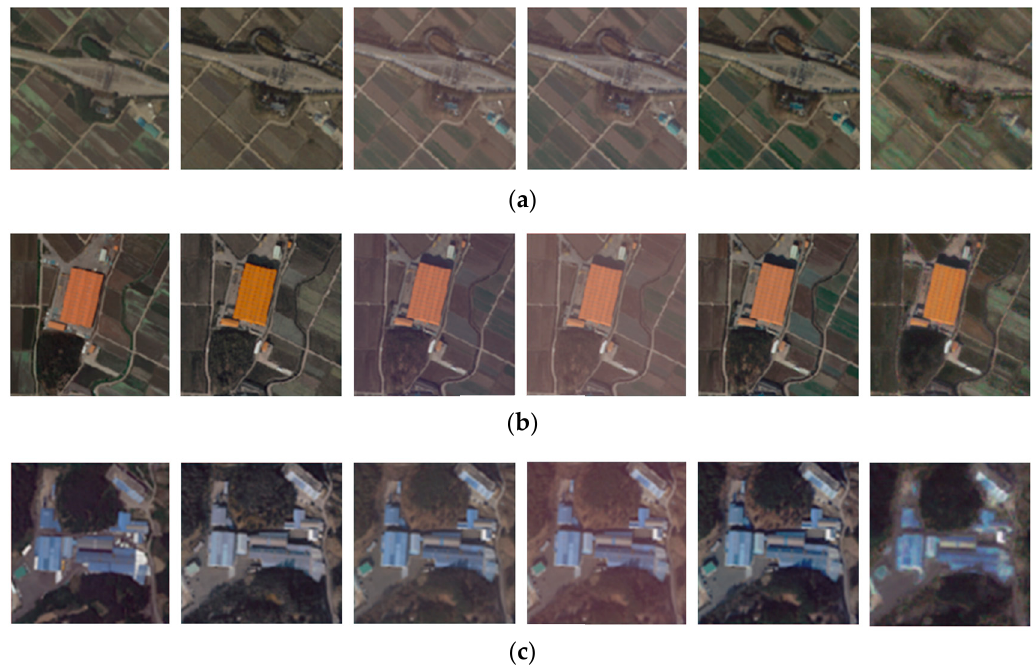
Figure 9. Enlargement of the built-up area marked with a red rectangle: ( a ) site 1, ( b ) site 2, ( c ) site 3. From left to right: reference image, proposed method, MS, NC, histogram matching, and RF.